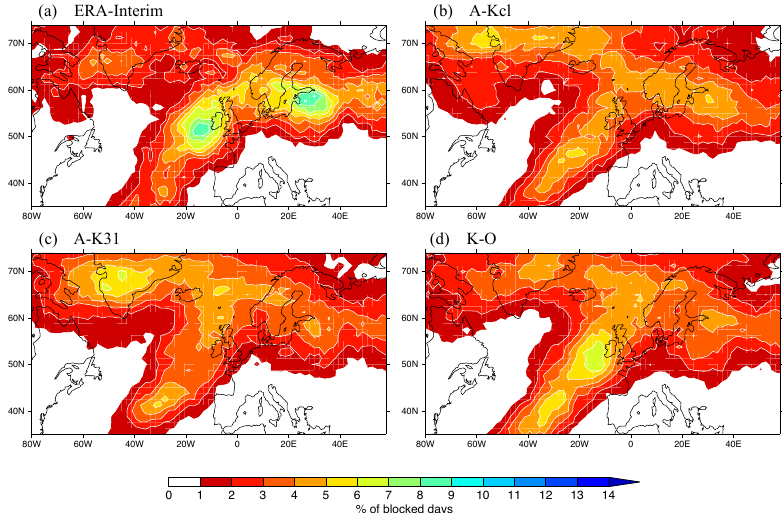
Figure 10. Euro-Atlantic springtime (MAM) blocking frequency climatology using the absolute geopotential height index calculated from the 500hPa geopotential heights after Tibaldi and Molteni (1990) and Scherrer et al.